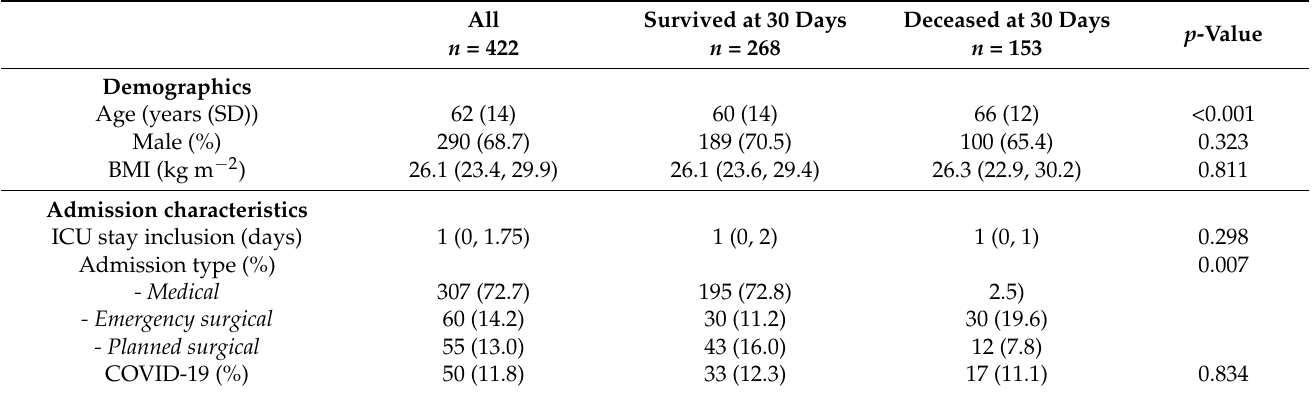
Table 1. Baseline